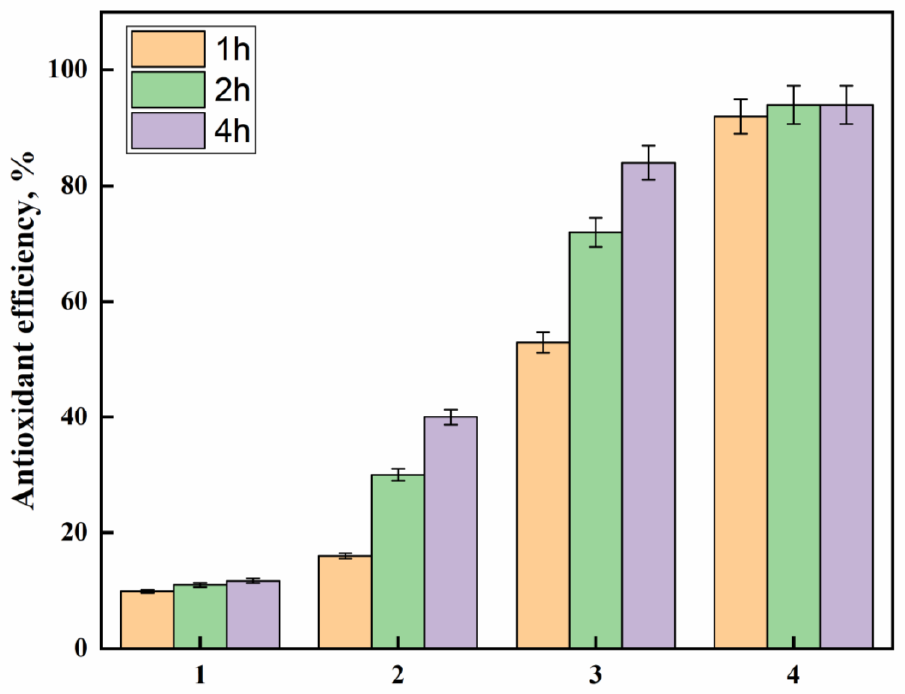
Figure 7. The DPPH antioxidant efficiency at different times for (1) PET, (2) PET hydrazide, (3) PET hydrazide-AgNP-PDA, and (4) PET hydrazide-AgNP.